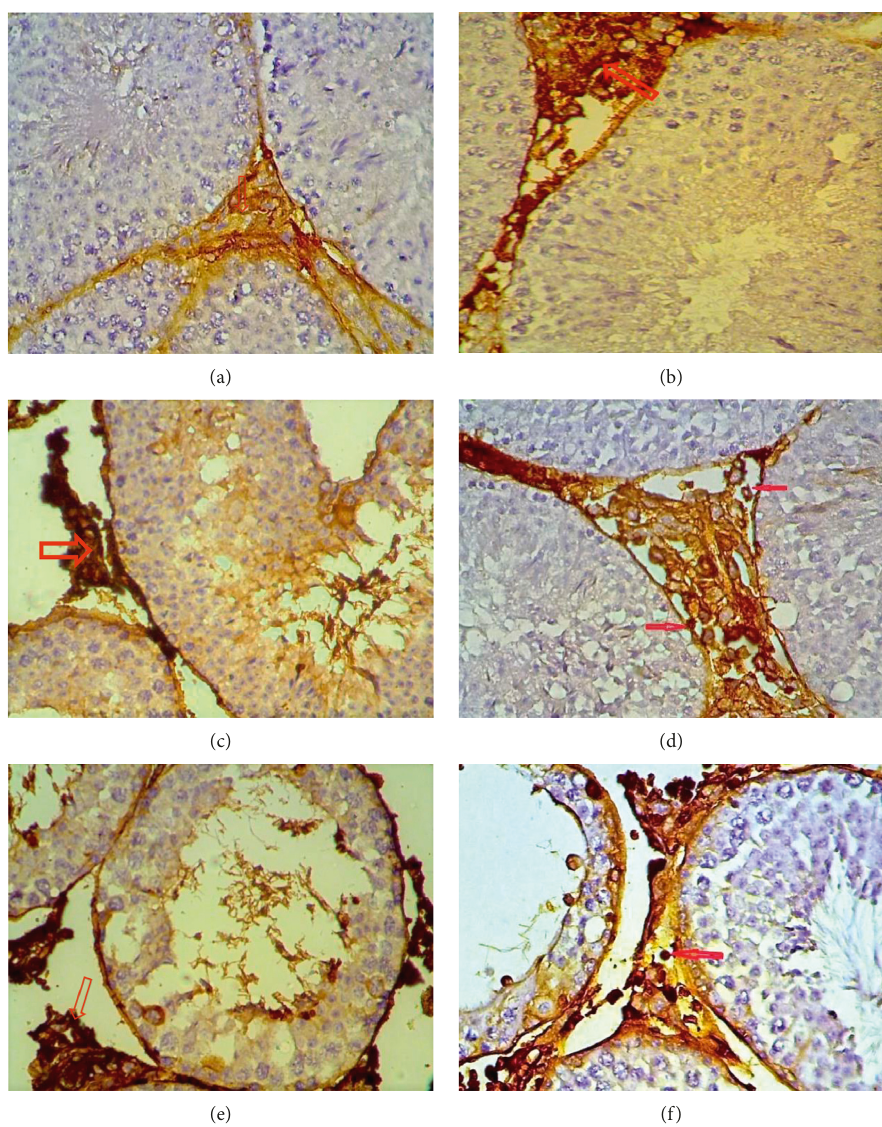
Figure 9: Immunohistochemical staining method detection of CD68 using a section of mice testis tissue subjected to different treatments (CuSO 4 and CuO NPs at 25 and 35mg/kg). Strong positive expression: (a) CuSO 4 .T1; (b, c) CuO.T1; (d) CuSO 4 .T2; (e, f)